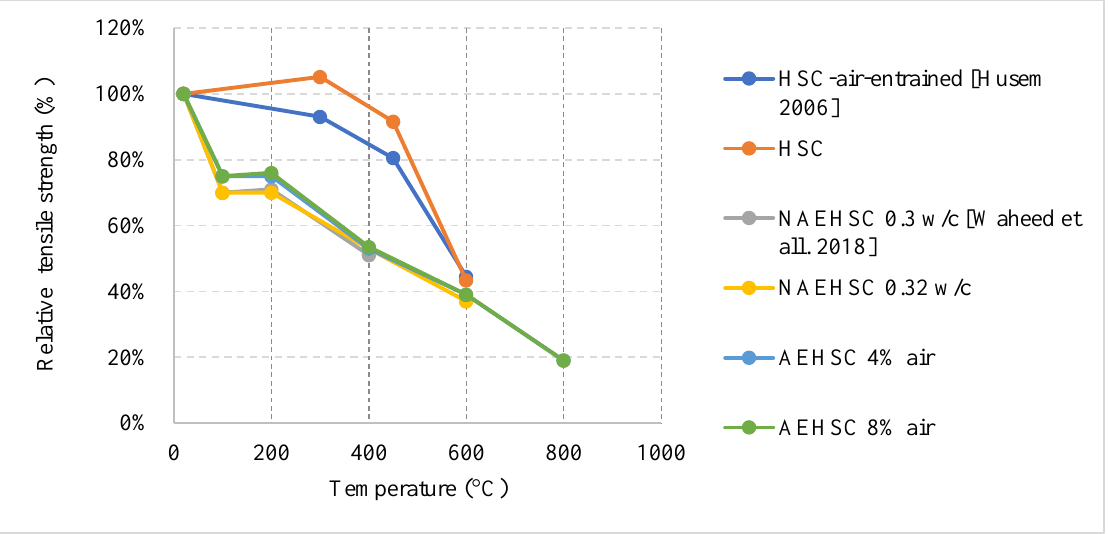
Figure 16. Relative tensile strength of naturally cooled HSC with different constituents. NAEHSC: Non-Air-Entrained High Strength Concrete, AEHSC: Air-Entrained High Strength Concrete [67,76].